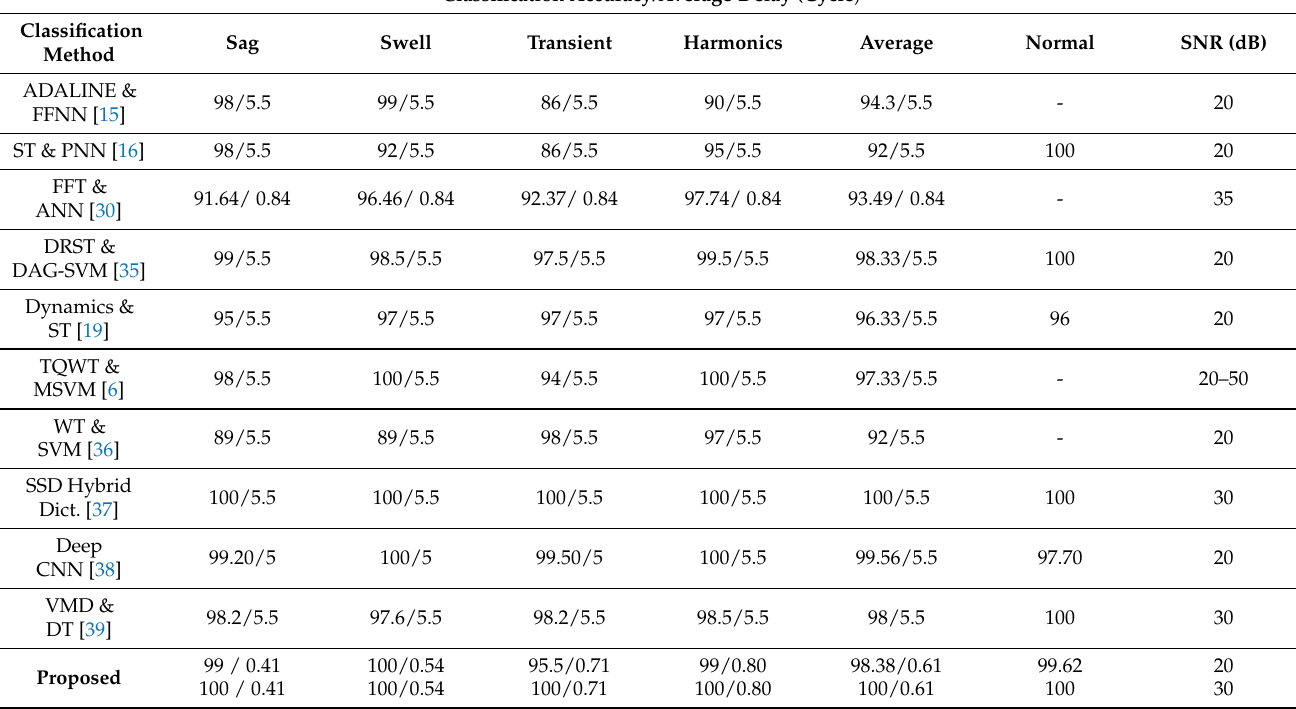
Table 3. Performance comparison for classification of sag, swell, oscillatory transient, and harmonics. The performances are presented in terms of the classification accuracy, the average delay of correct classification, and false alarm (false classification of the normal signal as a